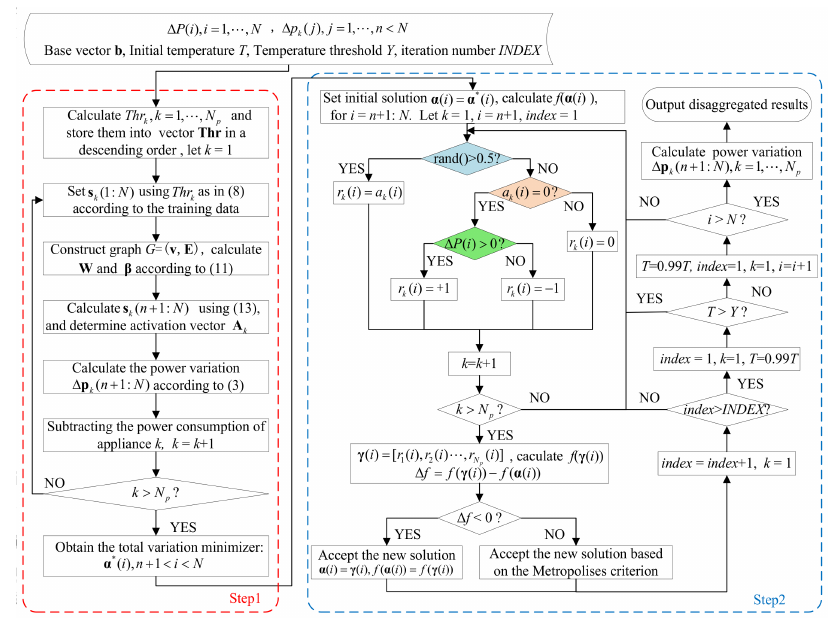
Figure 1. Flow chart of the proposed GSQF-APD